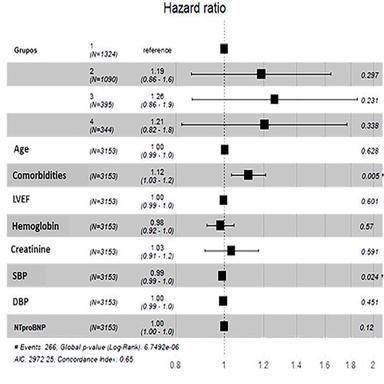
Kaplan-Meier curves according to patient group (left) and box-plot of the adjusted Cox regression analysis. DBP: diastolic blood pressure; LVEF: left ventricular ejection fraction; SBP: systolic blood pressure.